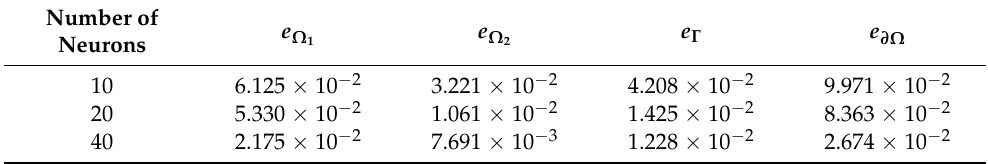
Table 14. Comparison of errors in different terms with different numbers of neurons for Example